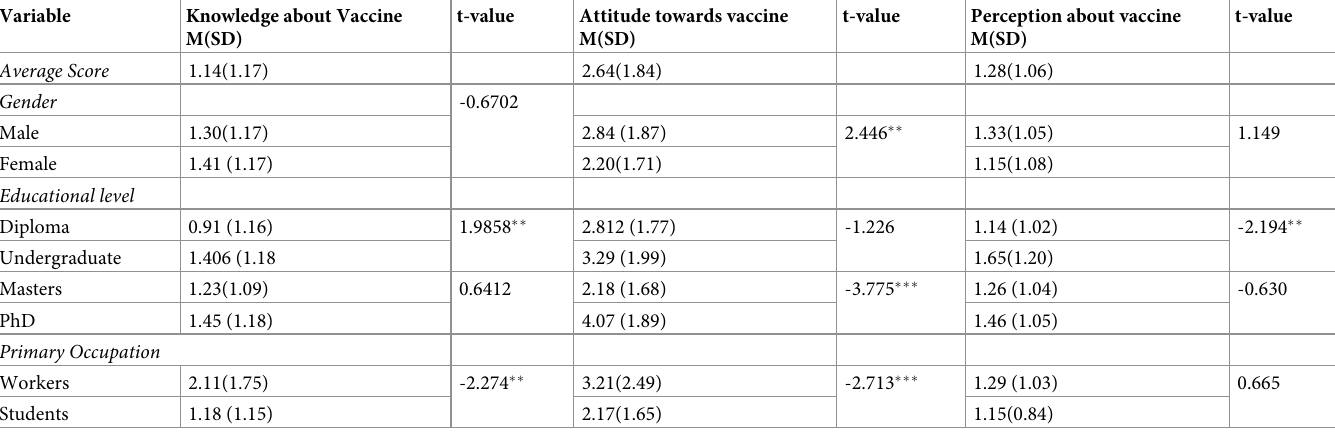
Table 5. Group difference analysis (bivariate) with knowledge, attitude and perception